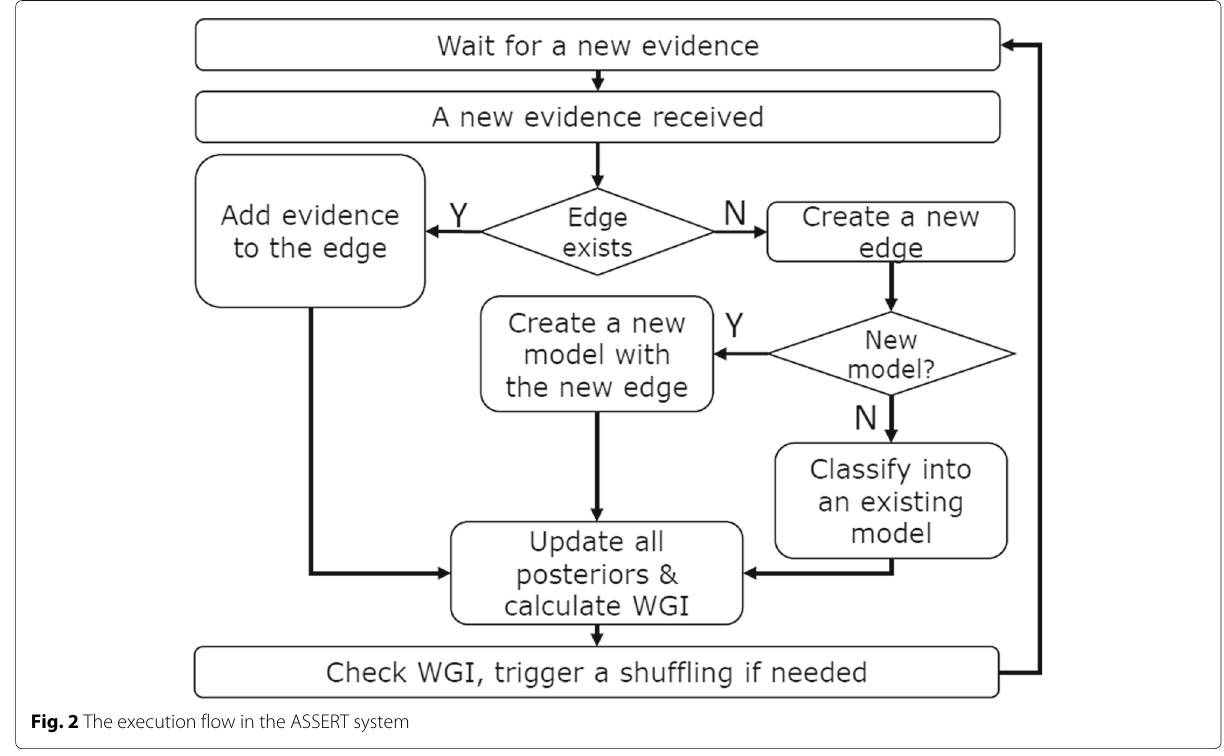
Fig. 2 The execution flow in the ASSERT system